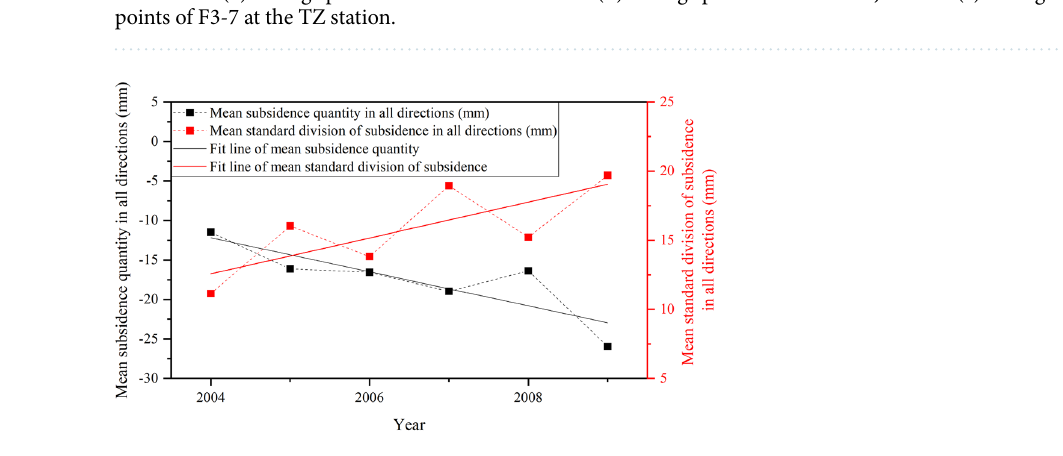
Figure 7. The time-series mean amount of subsidence and mean standard division of subsidence in all directions. The dashed black line is the time-series mean amount of subsidence in all directions. The dashed red lineis the time-series mean standard division of subsidence in all directions. The solid black line is the linear fit of the mean subsidence. The solid red line is the linear fit of the mean standard division of